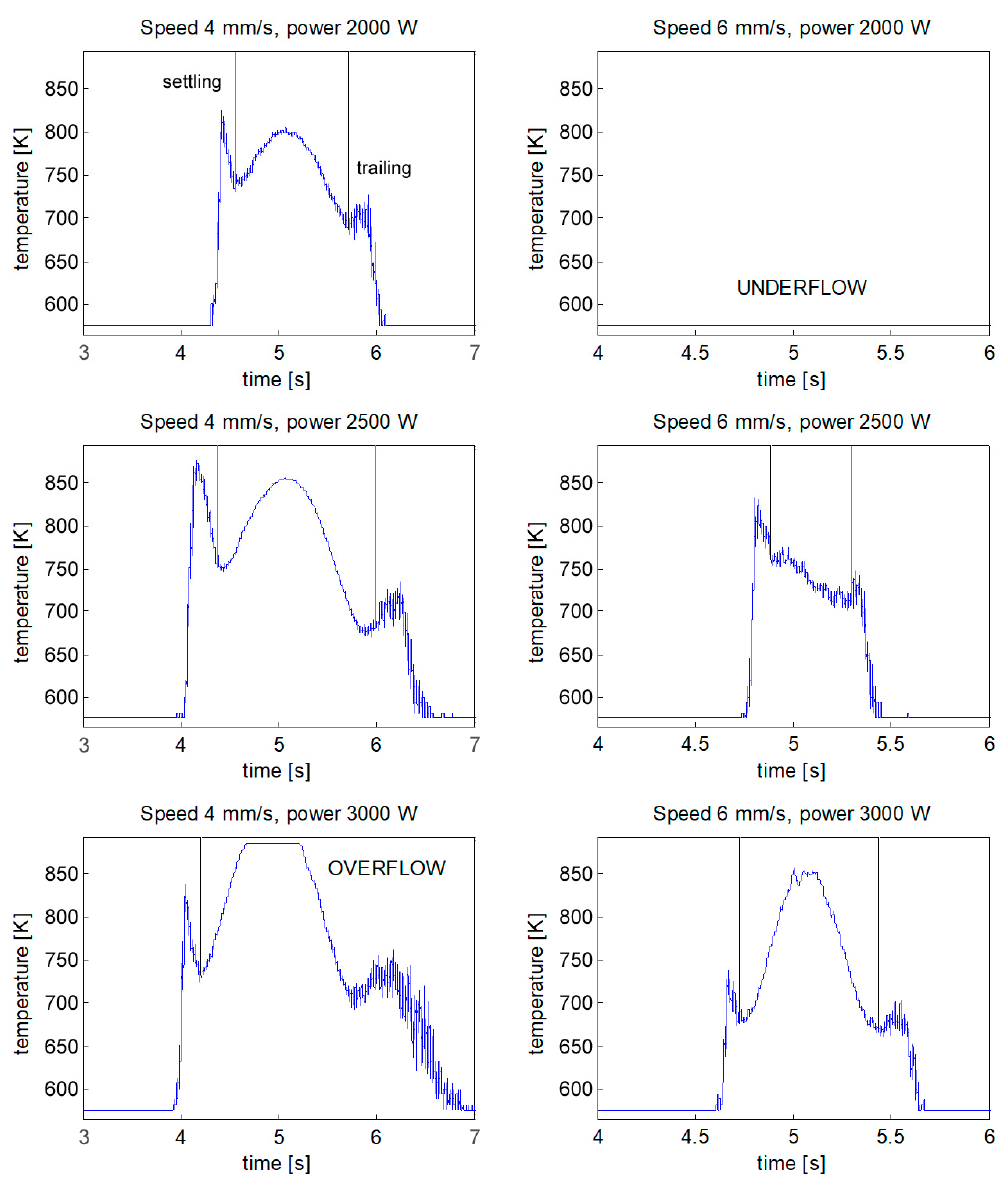
Figure 9. Thermal history of the site of interest as pyrometer output.